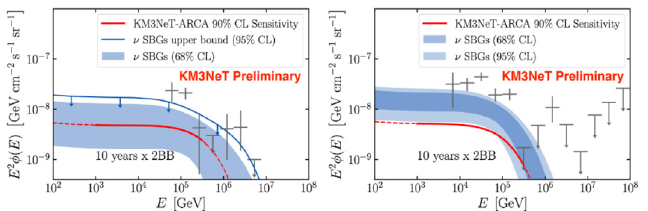
Figure 1. Left The 90% C.L. sensitivity (red curve) is compared with the corresponding theoretical 1 σ uncertainty band of the SBG spectral energy distribution according to the analysis of [4]. This band has been obtained by fitting the Fermi-LAT EGB and the IceCube HESE data. the IceCube HESE measurements [8] are also shown for reference. Right The sensitivity is compared with the corresponding theoretical 1 2 σ uncertainty band of the SBG spectral energy distribution according − to the analysis of [4], considering EGB Fermi-lat and (6-year) of IceCube CASCADE samples. The IceCube cascades measurements ([9]) are shown for reference.